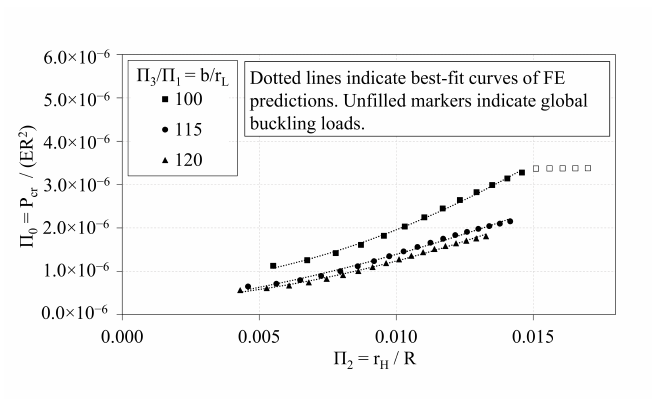
Figure 7. OLC Π 0 vs. Π 2